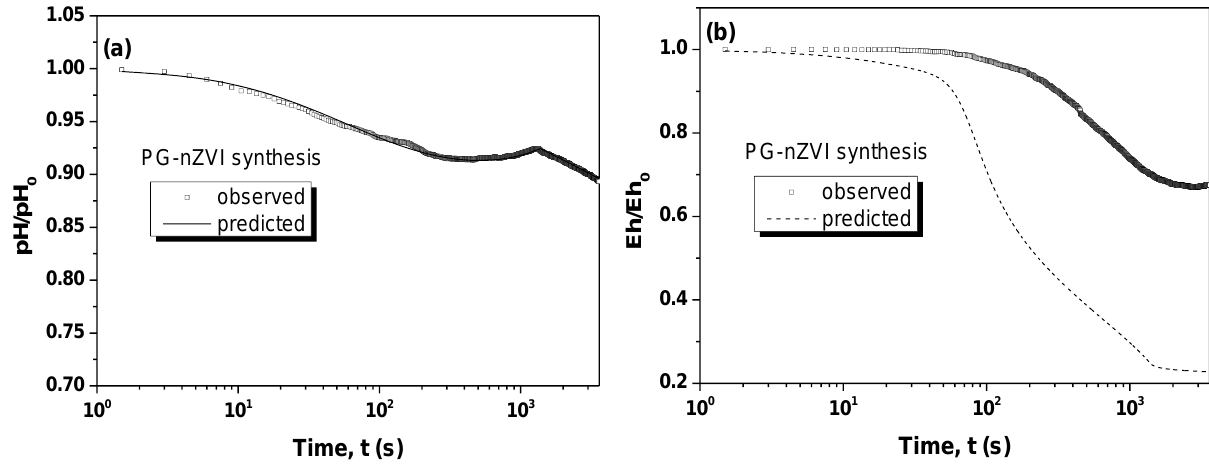
Figure 10. Comparison of experimentally measured with numerically predicted (a) pH/pH 0 , and (b) E h /E h0 , when ferrous ions are reduced to zero valent iron by the polyphenols of Pomegranate extract (PG-nZVI).